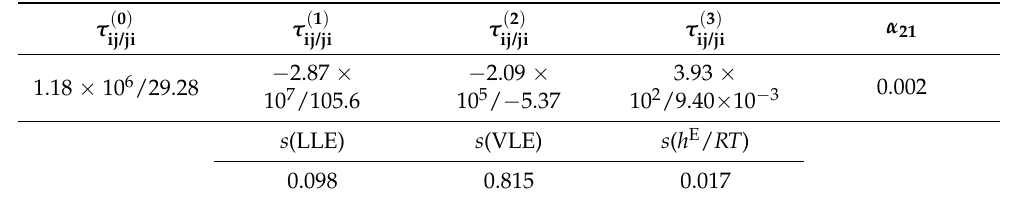
Table 2. Parametrization of NRTL using parameters from literature *, obtained using the multi- property approach for the binary methyl methanoate (1) + pentane